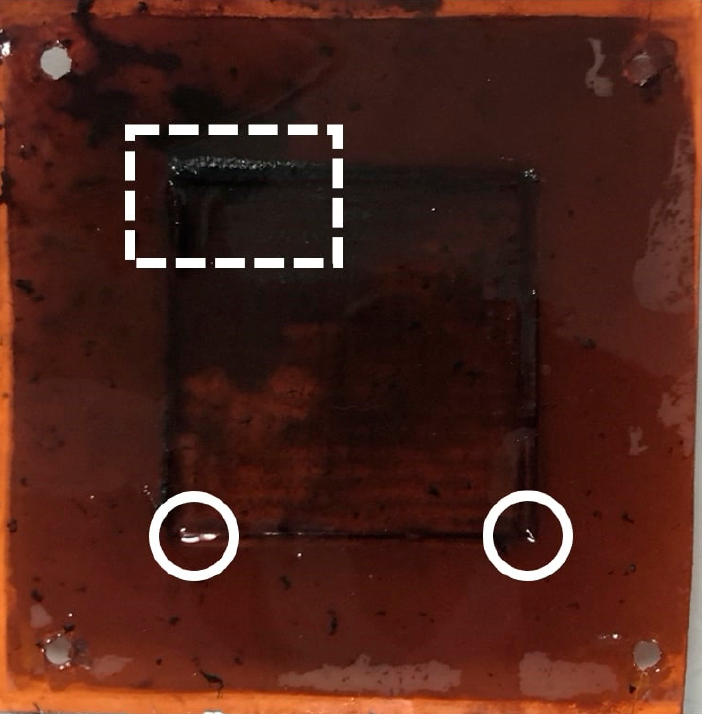
Figure 8. Warped and holed PVIB-10 membrane after repeated use. The total area of the membrane is a square of dimensions 7 cm × 7 cm.